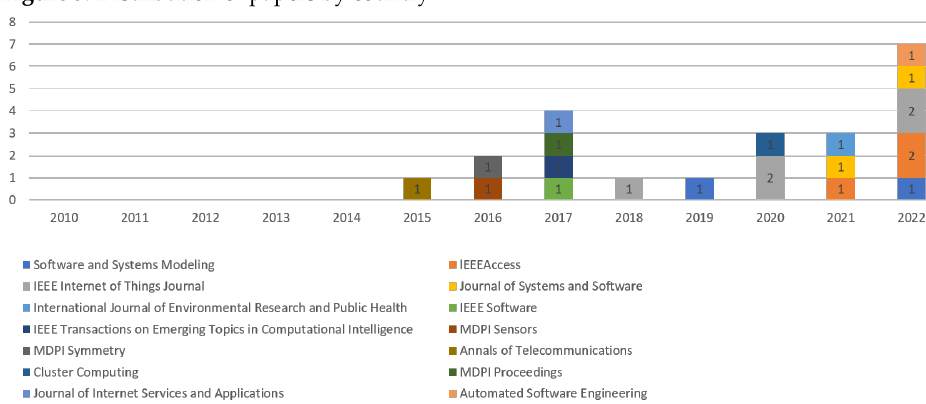
Figure 5. Distribution of papers by country.